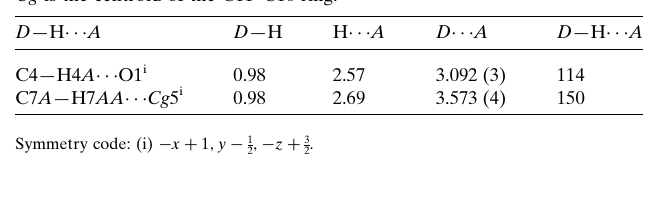
Table 1 Hydrogen-bond geometry (A˚ , (cid:4) ). Cg is the centroid of the C11–C16 ring.